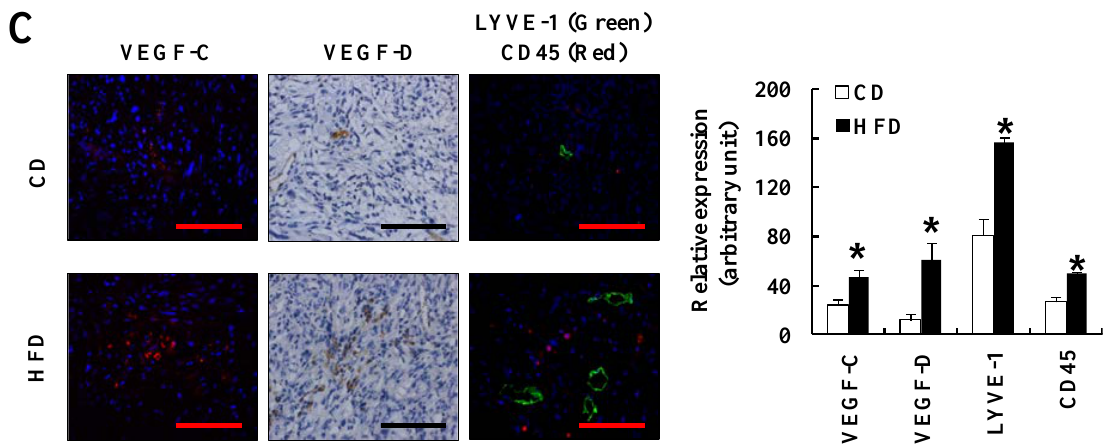
Figure 2. HFD feeding increases tumor proliferation, angiogenesis, and lymphangiogenesis in the TRAMP-C2 allograft model. Four-week-old, male C57BL/6J mice were fed a CD or HFD for a period of 24 weeks. After 24 weeks, TRAMP-C2 cells were subcutaneously injected into the right rear flanks of the mice. Eleven weeks after the TRAMP-C2 cell injection, all mice were sacrificed and tumors were isolated. Tumor sections were stained with the indicated antibodies, and nuclei were counterstained with hematoxylin or DAPI. ( A ) Representative images of IHC staining for proliferation-related proteins (upper panel) and quantification results (lower panel) are shown; ( B ) Representative images of IHC staining for angiogenesis-related proteins (left panel) and quantification results (right panel) are shown; ( C ) Representative images of IHC staining for lymphangiogenesis-related proteins (left panel) and quantification results (right panel) are shown. Each bar represents the mean ± SEM ( n = 8). * p < 0.05 as compared with the CD-fed group. Scale bar, 100